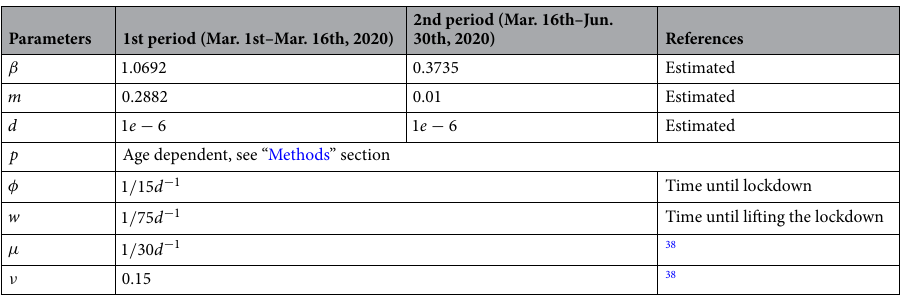
Table 1. Summary of the parameter values used in the simulations presented along the text.